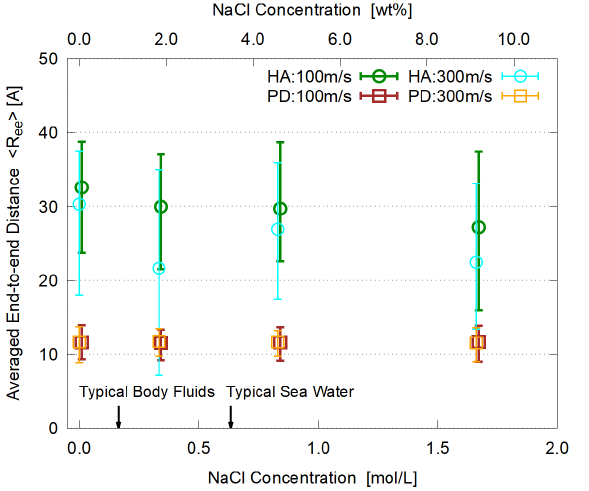
Figure 11. Salt concentration dependence of the averaged end-to-end distance with minimum and maximum, time-averaged for 3ns ≤ t ≤